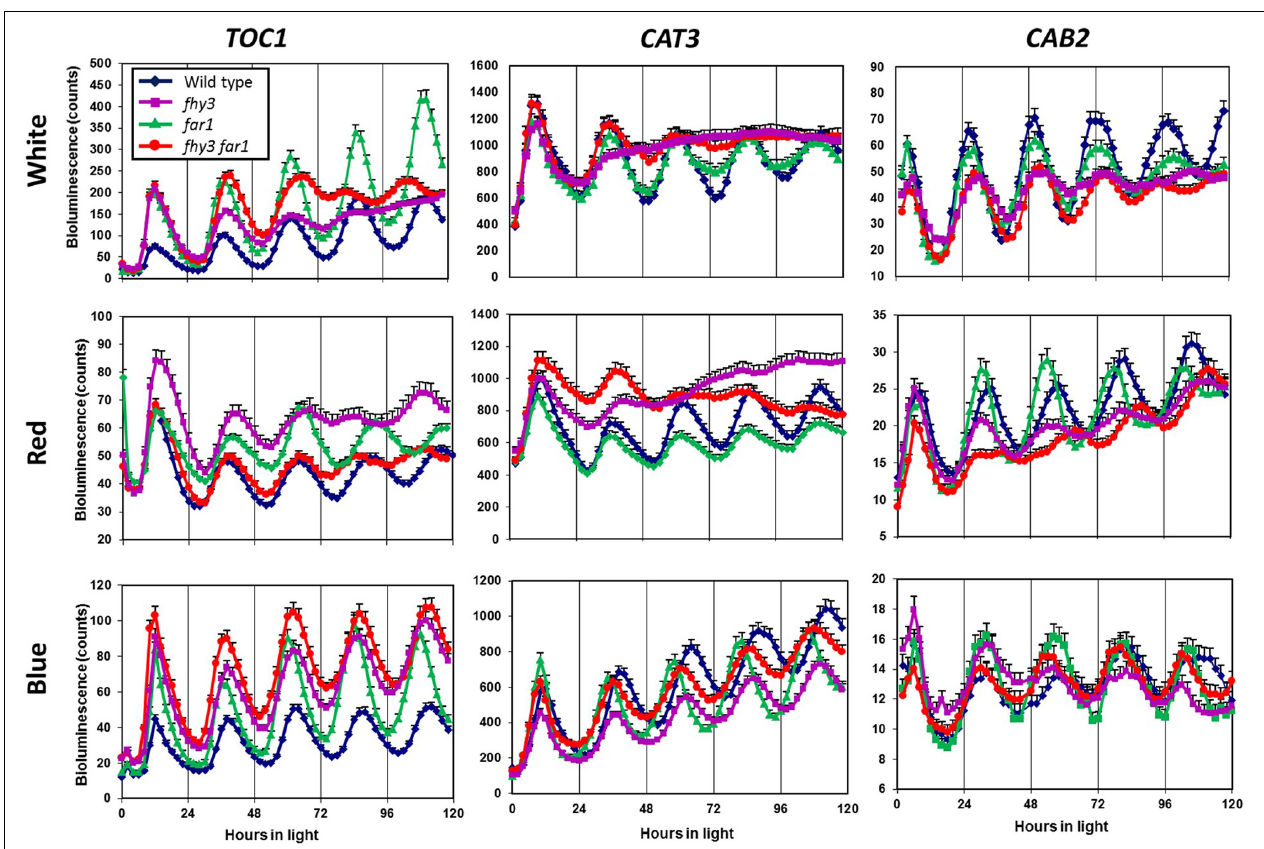
FIGURE 1 | Loss of FHY3 but not FAR1 results in arrhythmic expression of non-target genes in the presence of red light. Wild type, fhy3 , far1 , and fhy3 far1 mutant seedlings containing either the TOC1:LUC , CAT3:LUC , or CAB2:LUC transgenes were germinated and entrained in 12 h white light: 12 h dark cycles for 1 week before transfer to either constant white (red + blue), red or blue light. Luciferase bioluminescence was then recorded every 2 h. Data represent the means of at least 11 seedlings ± SE.